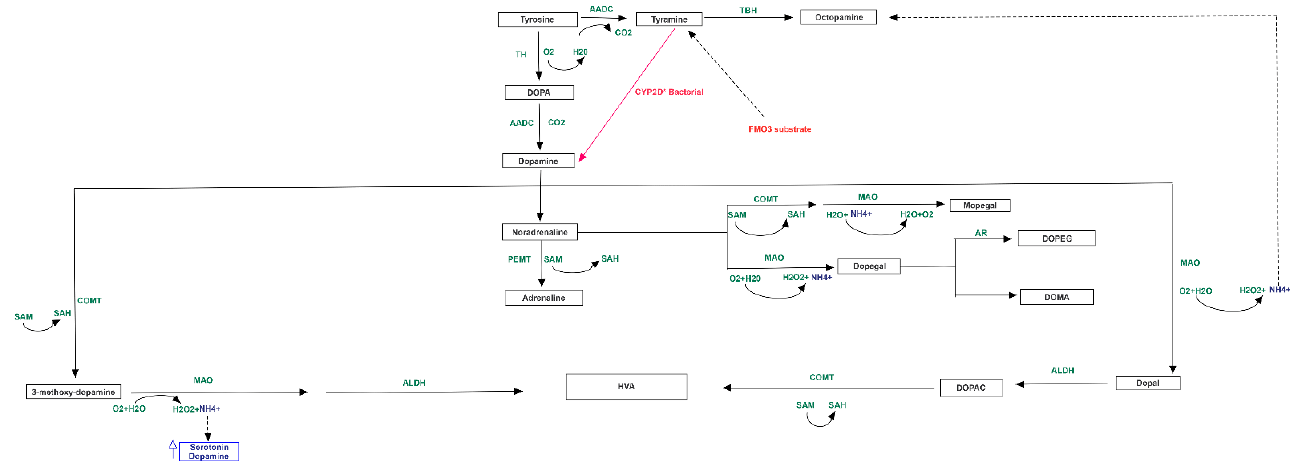
Figure 4. Metabolism of catecholamine and link to serotonin. The scheme also shows that tyramine, produced from tyrosine, is a substrate of FMO3. nitine oxidoreductase (Figure 5).